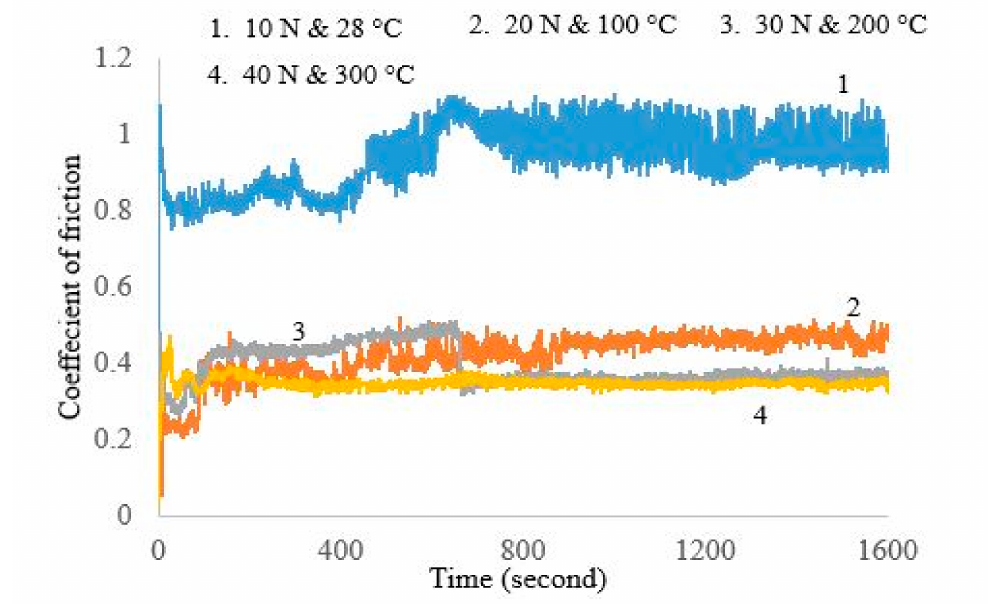
Figure 7. Friction coe ffi cients (COF) at a constant speed with increasing load and